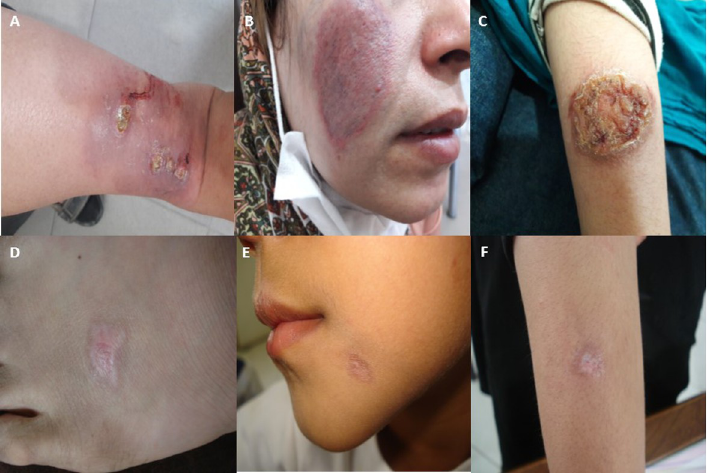
Fig 1. A, B and C; representative images of unresponsive cases, D, E and F; representative images of responsive cases with anthroponotic cutaneous leishmaniasis due to Leishmania tropica from a major focus, Kerman, southeast of